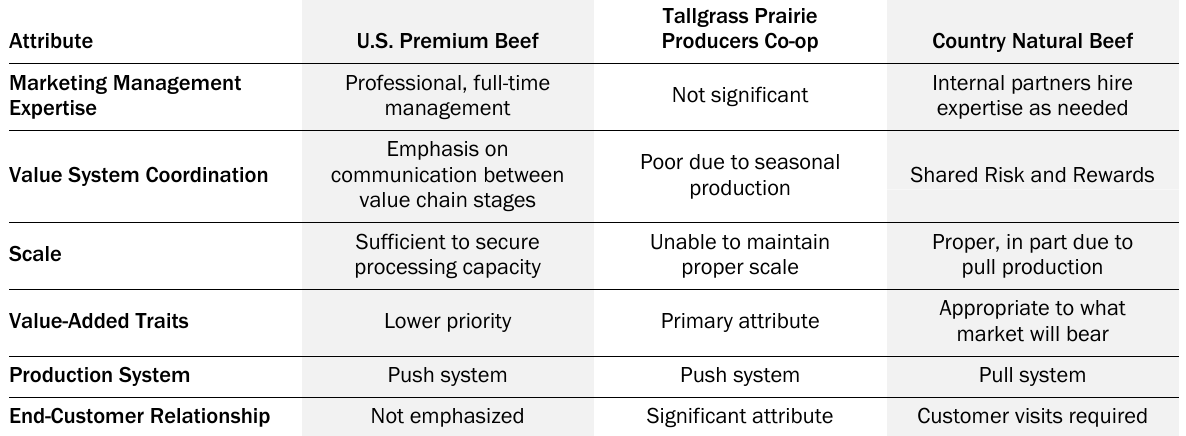
Table 1. Summary of Case Studies of Cooperative Business Models for Beef Marketing